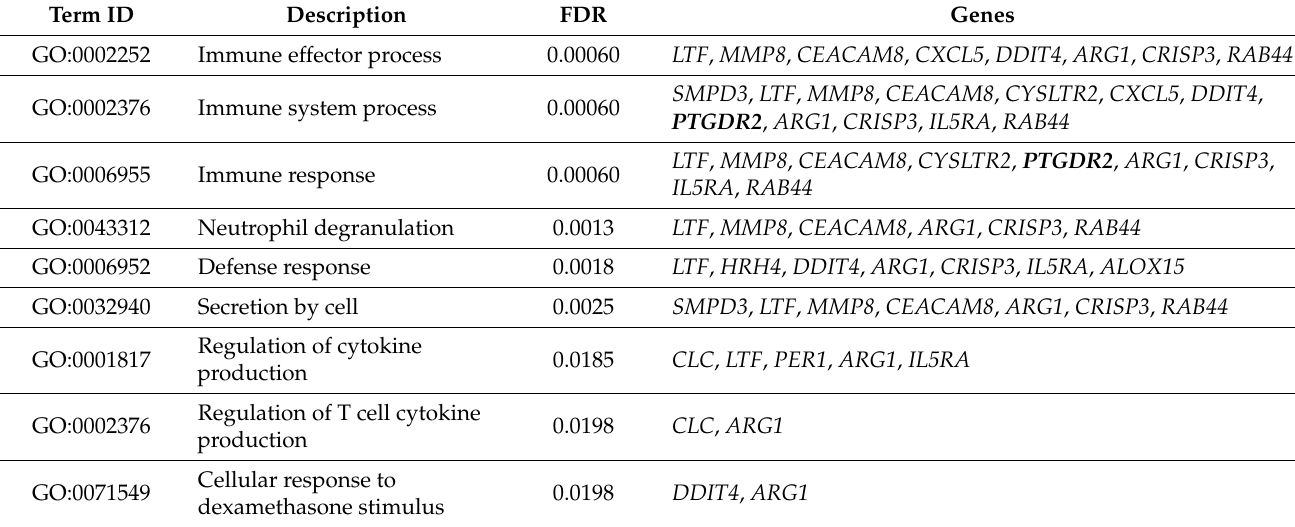
Table 3. Gene ontology biological process enrichment analysis for most differentially expressed genes. PTGDR2 gene is highlighted in